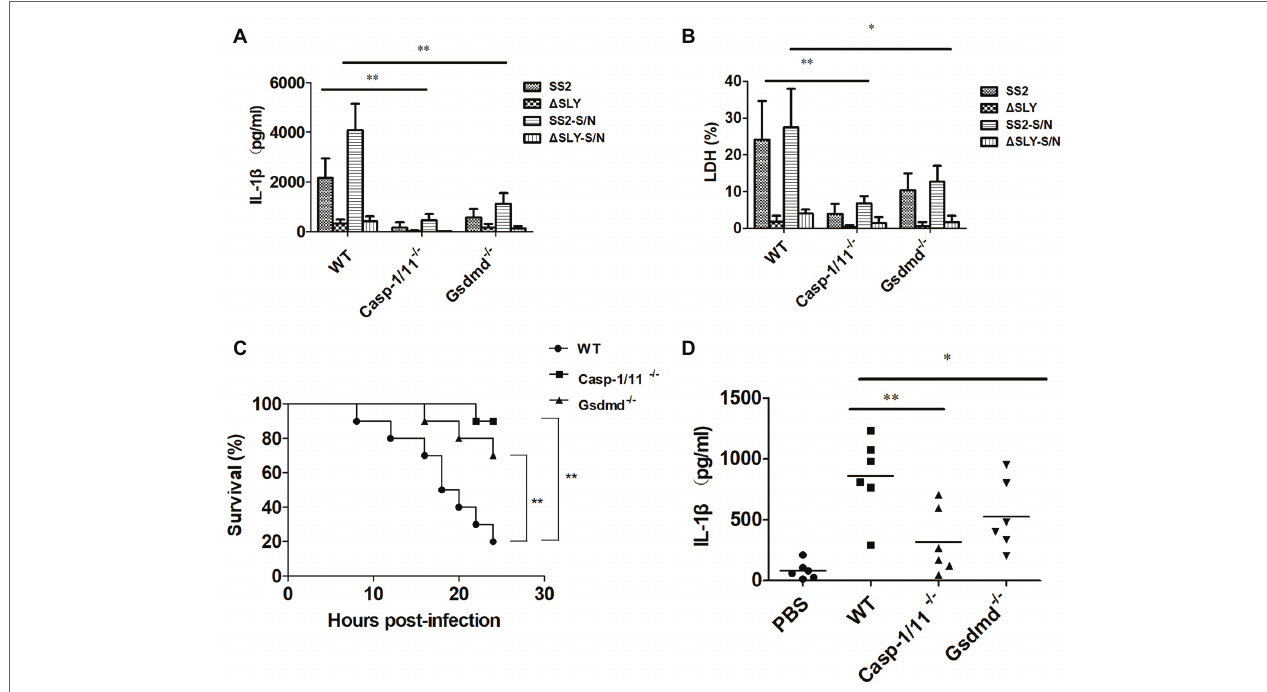
FIGURE 3 | The SS2-induced IL-1 β secretion was dependent on Caspase-1/11 and gasdermin D (Gsdmd) in vitro and in vivo . (A,B) BMDMs were isolated from 8-week-old WT C57BL/6J, Caspase1/11 -deficient (Caspase-1/11 −/− ) and Gsdmd -deficient (Gsdmd −/− ) mice, which were treated with SS2 (MOI, 1), ∆ SLY (MOI, 1), SS2-S/N (200 ng/ml), and ∆ SLY-S/N (200 ng/ml) for 16 h (LPS priming for 3 h was needed prior to the treatments of SS2-S/N and ∆ SLY-S/N). The supernatants were collected for the IL-1 β ELISA (A) and LDH assays (B) . (C) 8-week-old WT C57BL/6J, Caspase-1/11 −/− , and Gsdmd −/− mice were injected IP with a higher dose of SS2 (2 × 10 9 CFU in 200 μ l PBS) and monitored for 24 h for their survival, with 10 mice per group. The WT mice infected with SS2 were considered as the positive control group. (D) 8-week-old WT C57BL/6J, Caspase-1/11 −/− , and Gsdmd −/− mice were injected IP with a lower dose of SS2 (2 × 10 8 CFU in 200 μ l PBS). The wild-type (WT) mice infected with SS2 and PBS were considered as the positive and negative control group respectively. These mice were sacrificed 24 h after injection and their PLFs were harvested for the measurement of IL-1 β (six mice per group). The data in panels (A,B) are the means ± standard deviations from three independent experiments. The data in panels (C,D) are from one of two independent experiments. * p < 0.05; ** p <